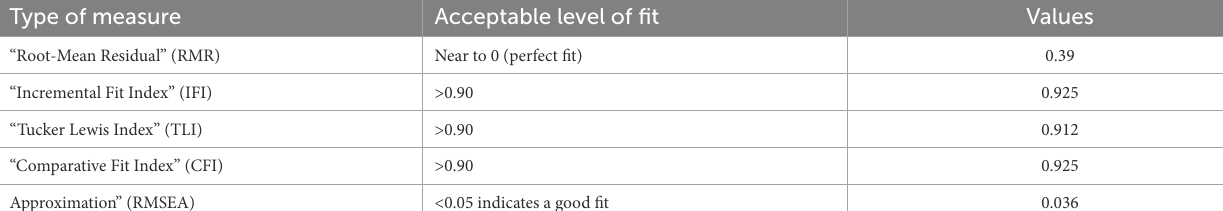
TABLE 4 Goodness of fit indices for the measurement model.